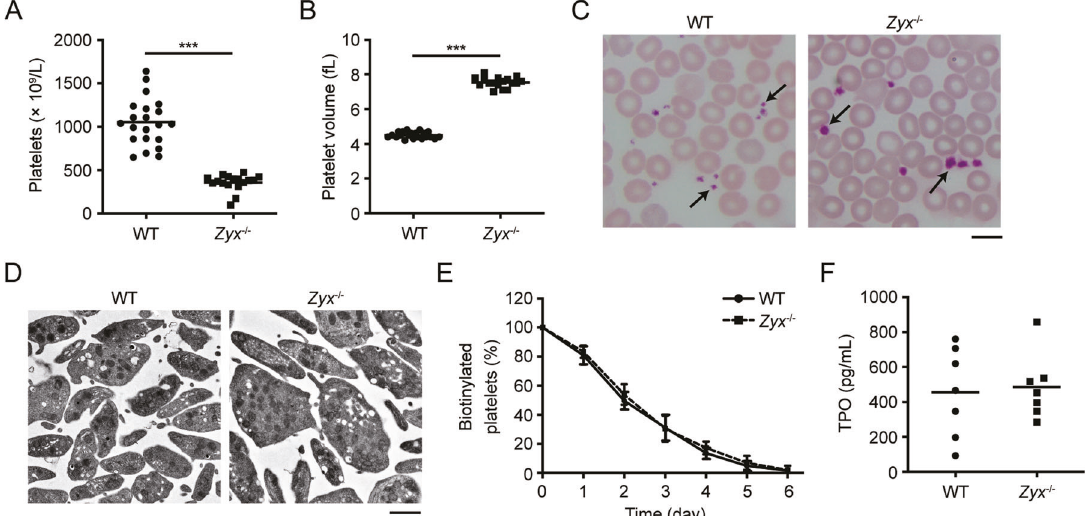
Fig. 1 Zyx − / − mice display macrothrombocytopenia. A, B Platelet count ( A ) and volume ( B ) were analyzed in whole blood from WT ( n = 21) and Zyx − / − ( n = 17) mice. Means are indicated by horizontal lines. *** P < 0.001 compared with WT mice by Mann – Whitney test in ( A ) and unpaired Student ’ s t -test with Welch correction in ( B ). C Representative images of Wright – Giemsa stained blood smears from WT and Zyx − / − mice (original magni fi cation × 1,000). Scale bar: 10 μ m. Platelets were indicated with arrows. D Representative transmission electron microscopy (TEM) images of WT and Zyx − / − platelets (original magni fi cation ×13,500). Scale bar: 1 μ m. Images were obtained from fi ve mice in each genotype in ( C ) and ( D ). E WT and Zyx − / − mice were intravenously injected with NHS-biotin, and peripheral blood was taken at the indicated time points after injection. The percentage of biotinylated platelets was determined by fl ow cytometry; n = 10 mice per genotype. Data are expressed as means ± SD. F Serum TPO levels in WT and Zyx − / − mice; n = 7 mice per genotype. Means are indicated by horizontal